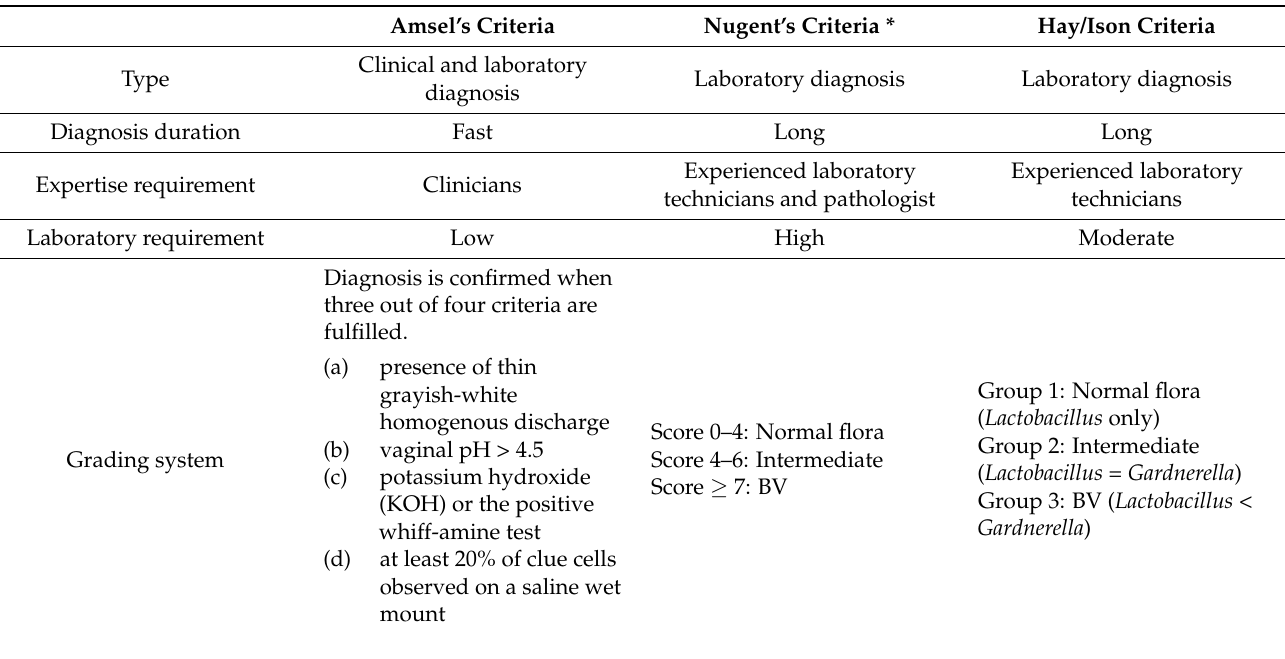
Table 2. Comparison between Amsel’s, Nugent’s, and Hay/Ison criteria (BV: bacterial vaginosis) (Adapted from Hainer and Gibson